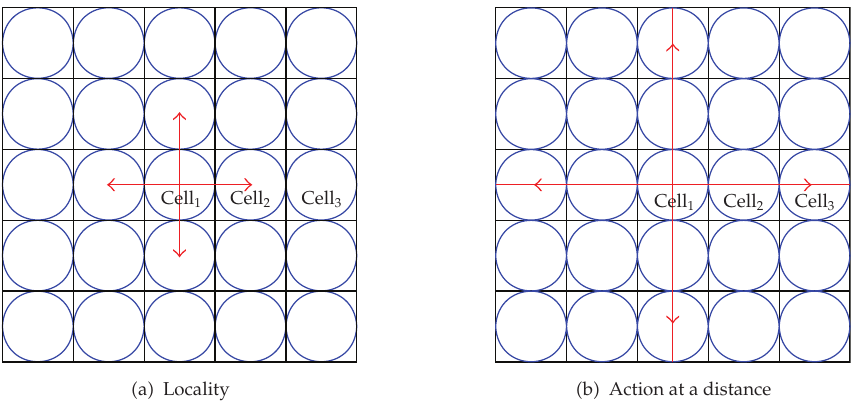
Figure 8: Sketch maps of locality and action at a distance of urban dynamics. In (cid:6) a (cid:7) indicative of locality, Cell 1 only acts on Cell 2 , not on Cell 3 , while in (cid:6) b (cid:7) indicating action at a distance, Cell 1 not only acts on Cell 2 , but also on Cell 3 , Cell 4 , and so